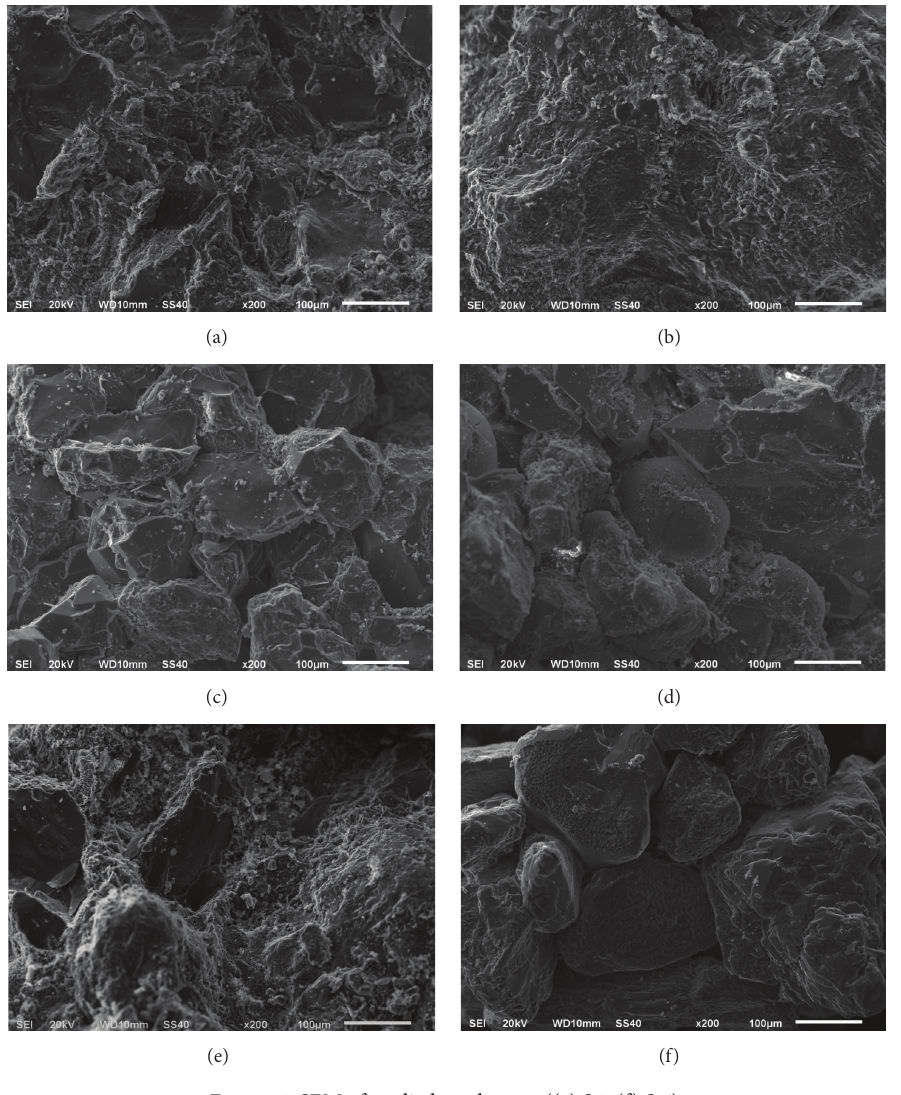
Figure 1: SEM of studied sandstones ((a) S 1, (f) S 6). Table 2: Fundamental properties of studied